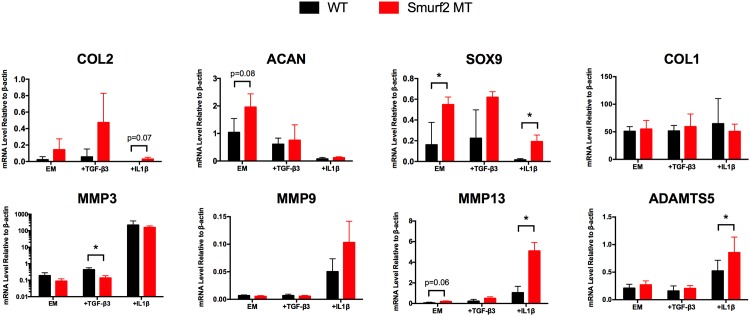
Quantitative gene expression analyses of key anabolic and catabolic markers in WT and MT iMACs. Cells were cultured as a monolayer on 2D tissue culture polystyrene for 4 days and treated with either 10 ng/mL of TGF-β3 or 5 ng/mL of IL-1β for 24 hours. Data are reported as the mean ± standard deviation of three separate chondrocyte isolations for each genotype. EM = Expansion Media, *p < 0.05 (p values approaching significance are noted on the graph).